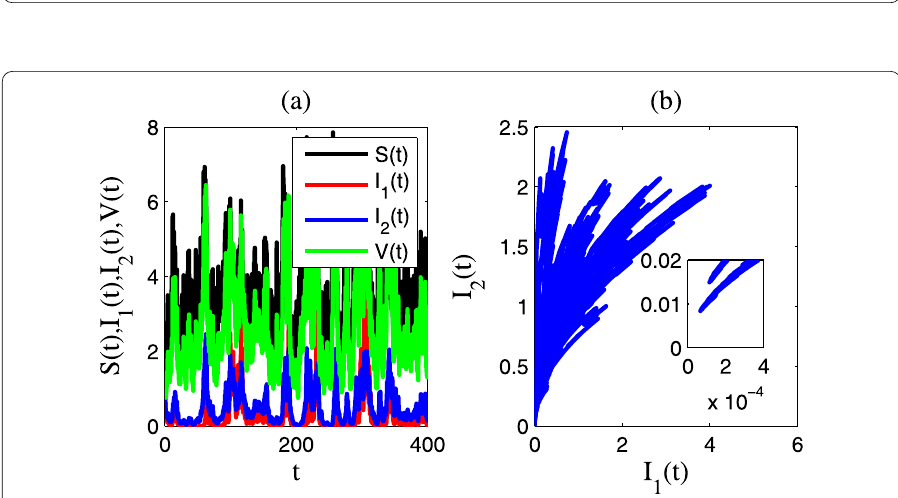
Figure 4 Time sequence diagram and phase diagram of model (4) for extinctions of disease 1 and persistence of disease 2.